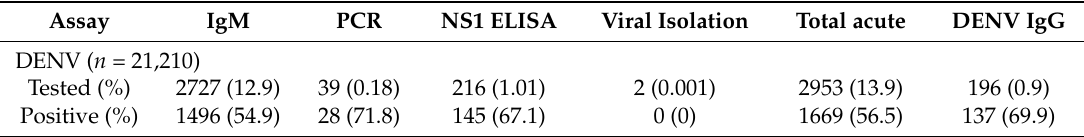
Table A1. DENV lab results by assay and